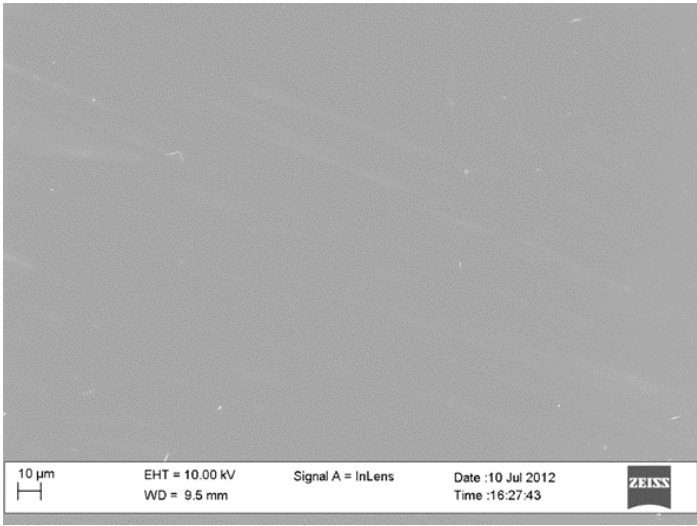
Figure 9. Image of the LYSO crystal surface acquired by a scanning electron microscope (SEM).